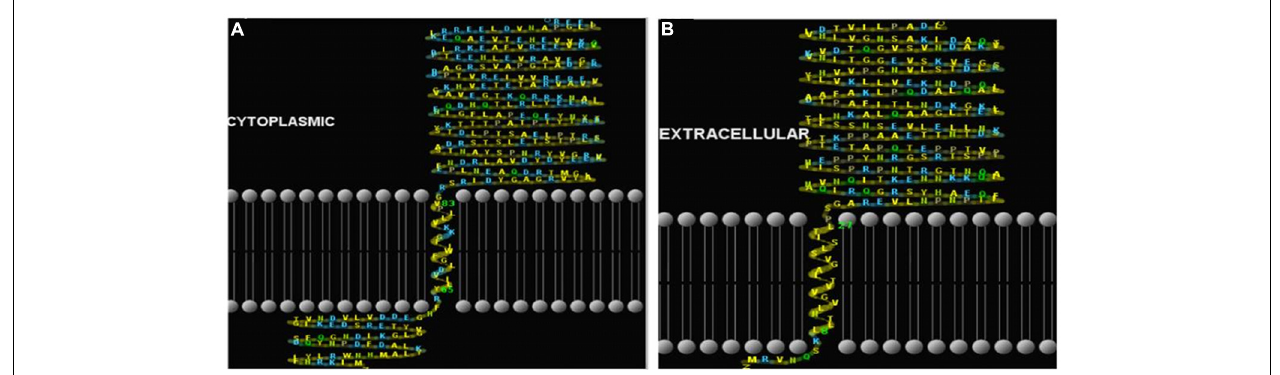
FIGURE 4 | Prediction of putative signal peptides and transmembrane helices of hypothetical proteins. (A) -all3797, and (B) -all4050 (http://www.cbs.dtu. dk/services/SignalP/) and HMMTop (http://www.enzim.hu/hmmtop/).